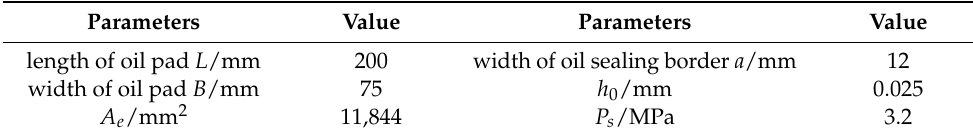
Table 1. Parameters of the hydrostatic bearing system.